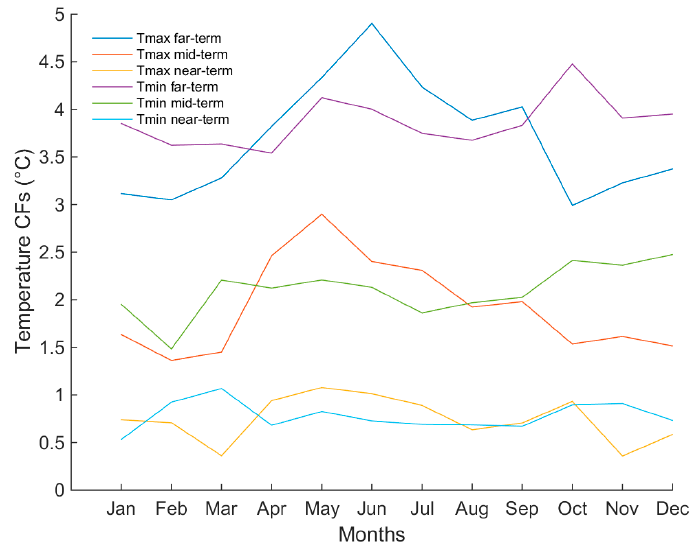
Figure 11. Seasonal variation of average temperature CFs (based on the three models) for the entire Awash basin (Tmax and Tmin maximum and minimum temperature, respectively). Table 2. Maximum and minimum temperature projections for the entire Awash basin for three periods and two